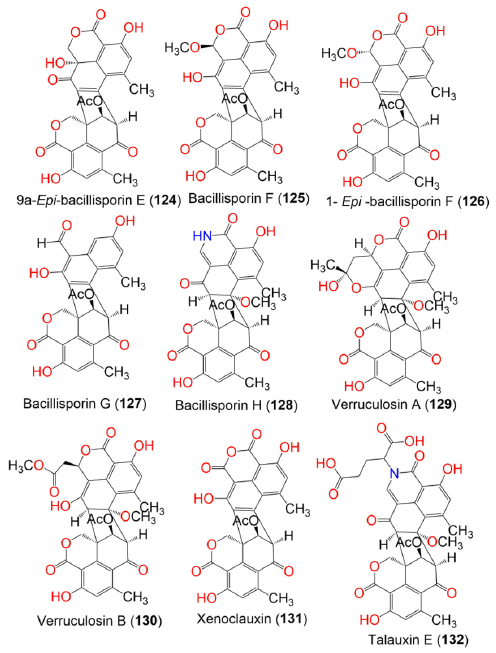
Figure 13. The structures of compounds 124 – 132 . Talaromyces verruculosus yielded two new oligophenalenone dimers, verruculosins A ( 129 ) and B ( 130 ), and the related known analogs, duclauxin ( 120 ), bacillisporin F ( 125 ), and xenoclauxin ( 131 ) (Figure 13). Compound 129 was a novel oligophenalenone dimer with a unique octacyclic skeleton. Compounds 129 and 130 were fully characterized by spectroscopic, X-ray crystallography, and ECD analyses as well as, optical rotation and NMR calculations. Compounds 120 , 125 , 129 , and 131 exhibited potent CDC25B inhibitory activities (IC 50 values of 0.75, 0.40, 0.38, and 0.26 µ M, respectively), compared